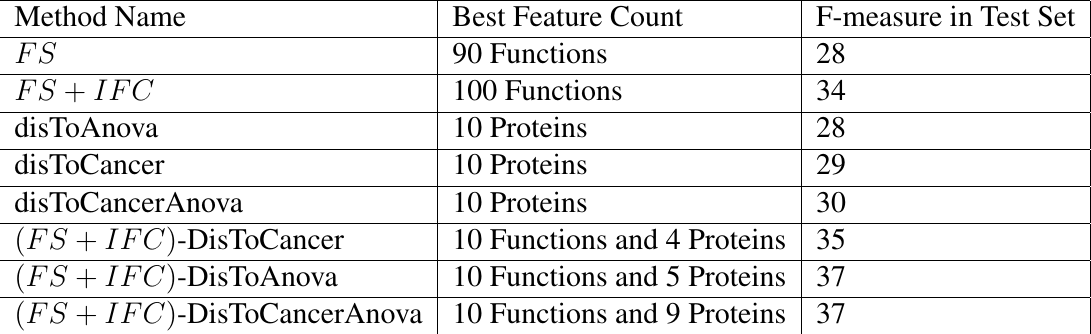
Table 8: Tuning result of each